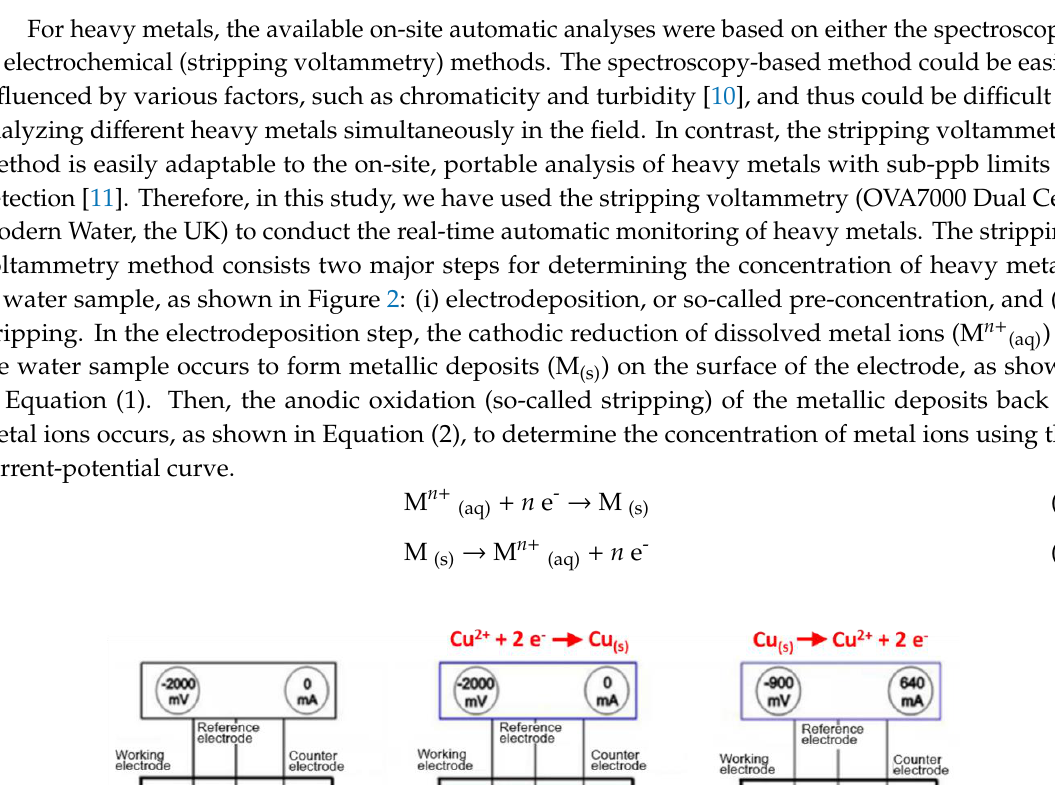
Figure 1. ( a ) Framework of general operations for automatic real-time monitoring systems based on cloud technology; ( b ) real-time automatic monitoring of heavy metals, powered by the solar power system.